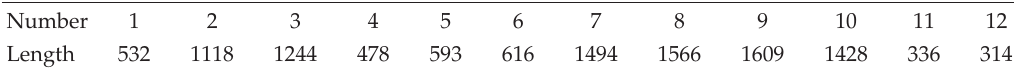
Table 1: The links